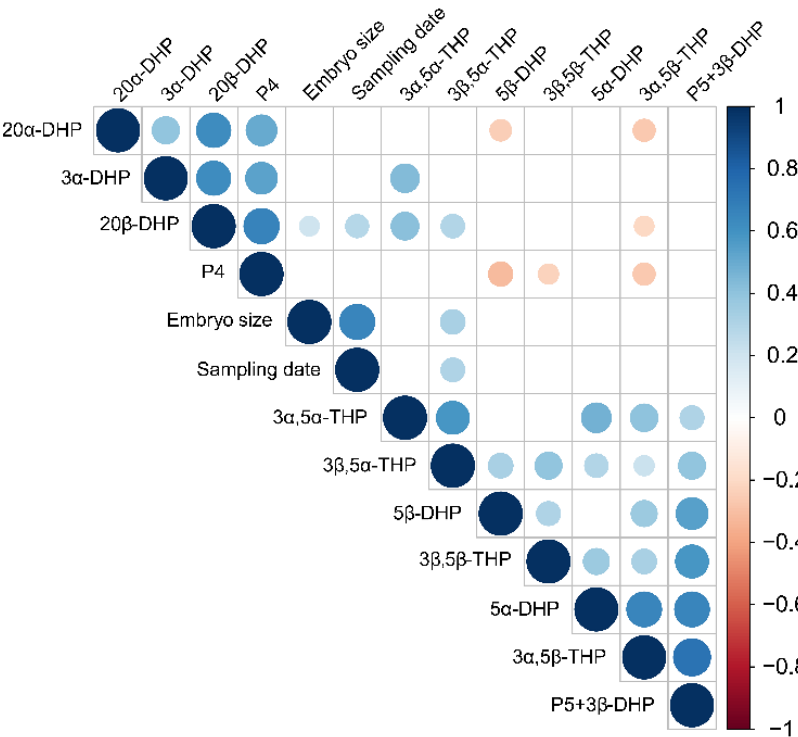
Figure 2. Pearson correlation plot with hierarchical clustering of the 11 progestogens, embryo size and sampling date. Significantly correlated variables (p < 0.05) are displayed and circle size and color indicate the degree of correlation (red and blue indicate a negative and positive